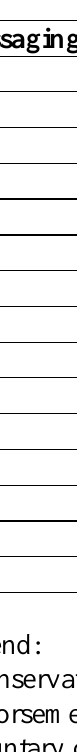
Table A1.1 City of Lincoln water conservation messaging.